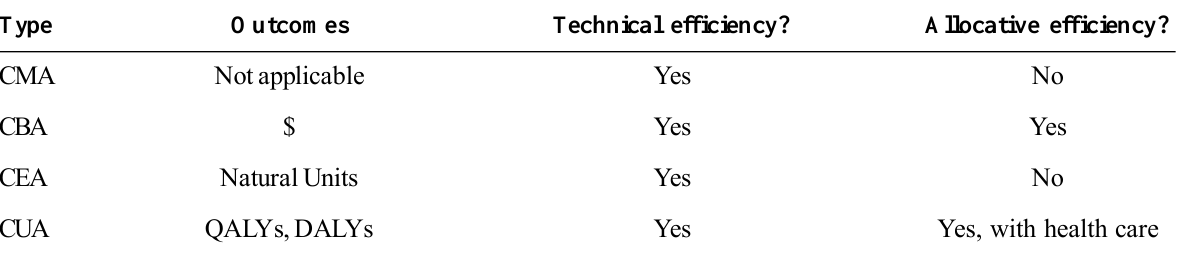
Table 2. Type of efficiency addressed through different types of economic